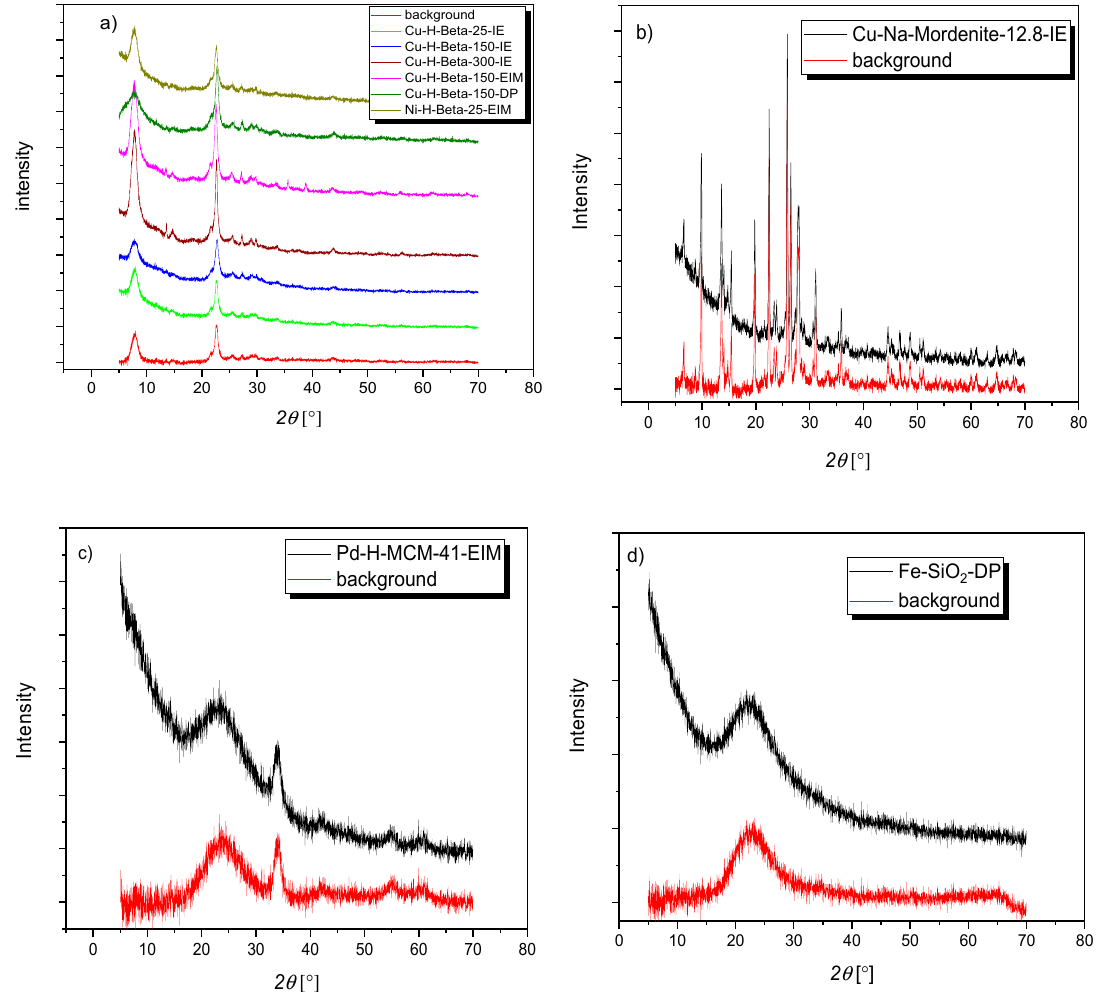
Figure 3. X-ray powder diffraction of ( a ) Cu-H-Beta-25-IE, Cu-H-Beta-150-IE, Cu-H-Beta-300-IE, Cu-H-Beta-150-EIM, Cu-H-Beta-150-DP, Ni-H-Beta-25-EIM, ( b ) Cu-Na-Modernite-12.8-IE, ( c ) Pd-H-MCM-41-EIM, and ( d ) Fe-SiO 2 -DP catalysts.